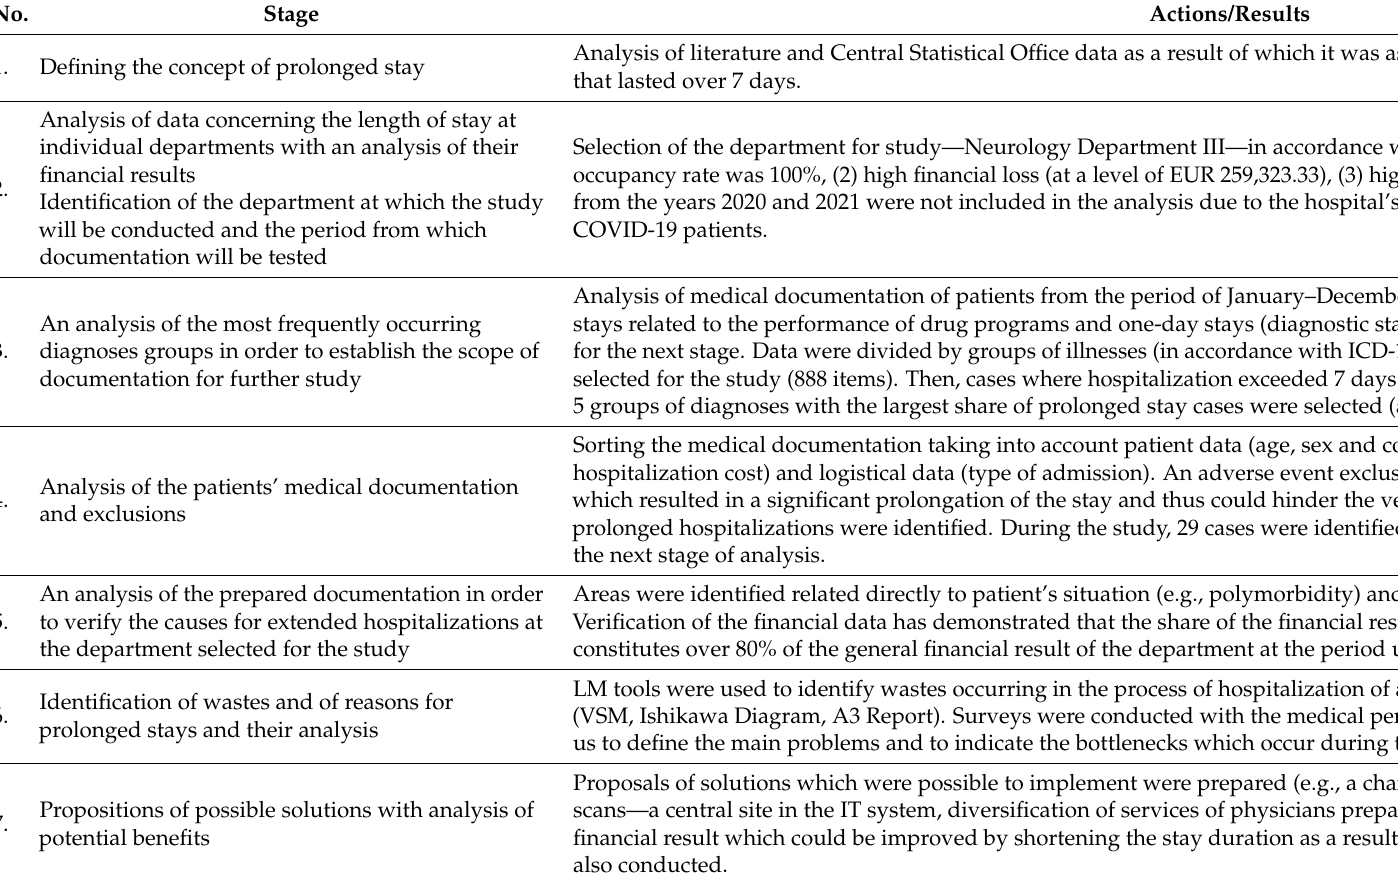
Table 1. Process of conducting the